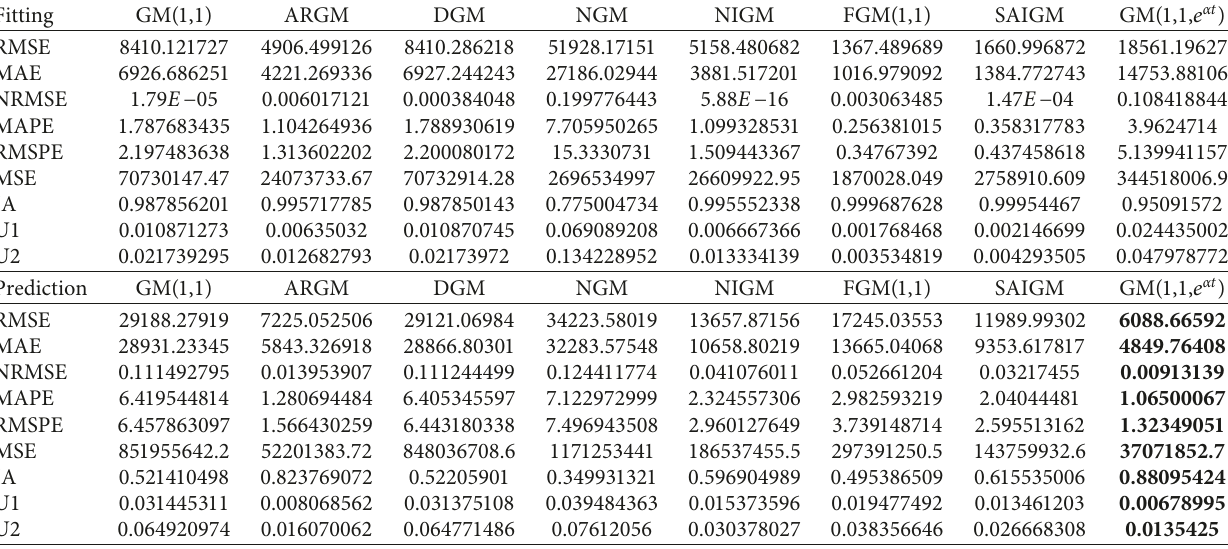
Table 9: Evaluation result of different grey models in Example